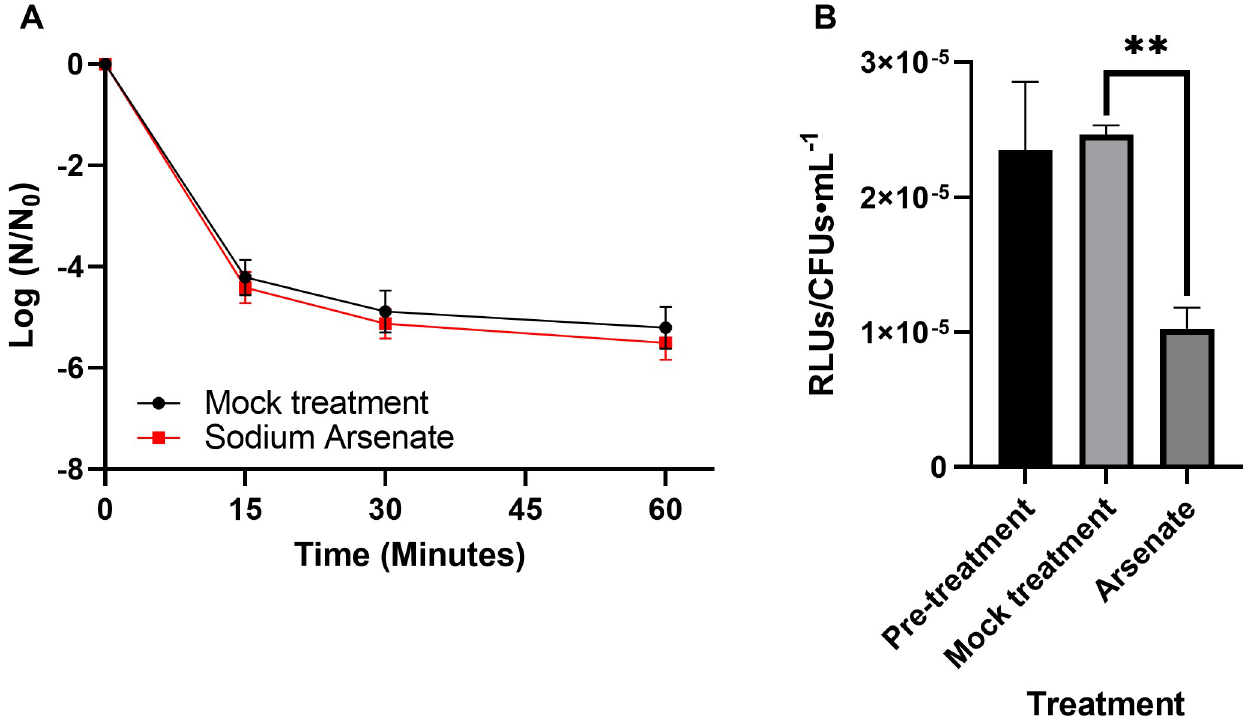
Fig 2. ATP depletion does not induce daptomycin tolerance. (A) Cells grown to exponential phase were treated with 10mM sodium arsenate or mock- treated for 30 min, then subjected to 30 μ g/mL daptomycin. Shown are the average log ratios of colony forming units ± standard deviations for n = 3 replicates; exact P -values are found in S4 Table. (B) ATP levels of pre-treated, mock-treated or arsenate-treated cells (30 min) were measured using the Promega BacTiterGlo kit. Shown are the average relative light units (RLUs) normalized to colony forming units ± standard deviations for n = 3 replicates. � P � 0.05; exact P -values are found in S4